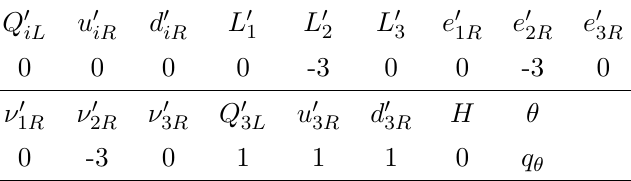
Table 1. The U (1) B charge assignments. A prime stands for a weak eigenstate Weyl fermion 3 − L 2 and the family index i takes values 1 and 2. The flavon charge q θ is a non-zero rational